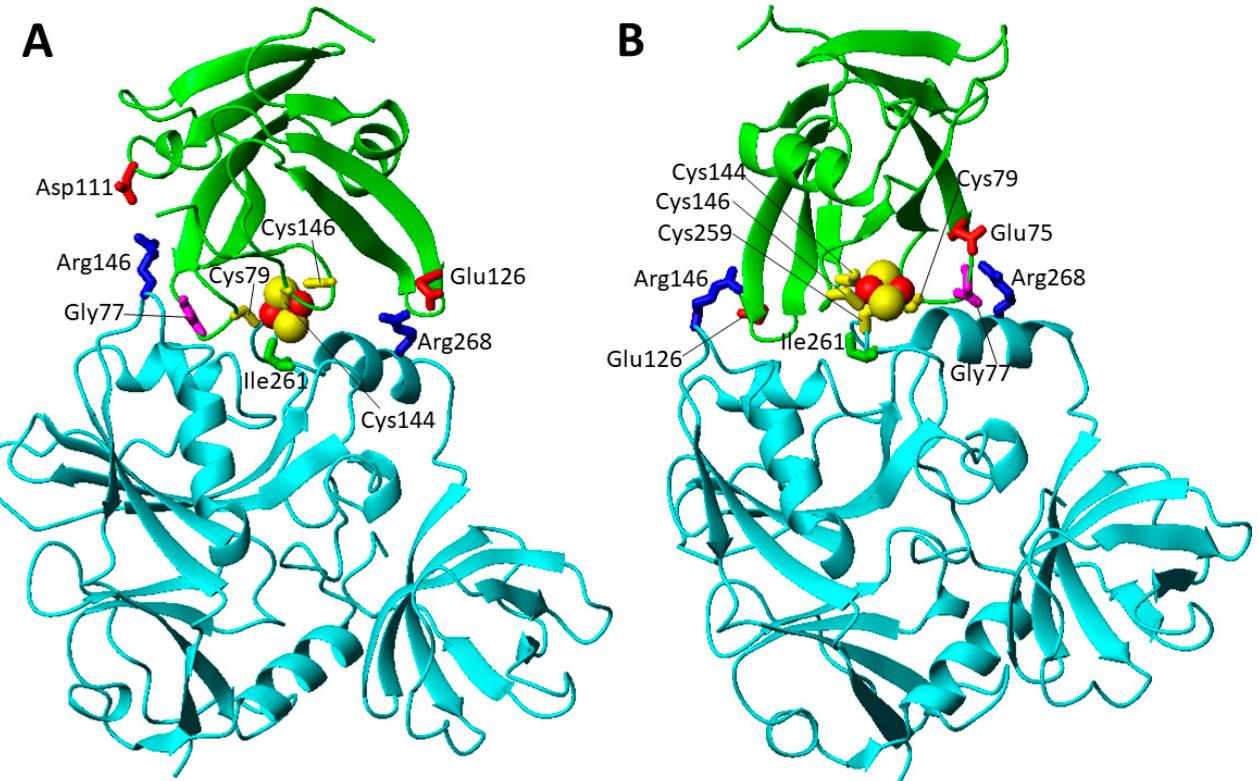
Figure 6. Effects of the pathogenic missense mutations on the heterodimeric [2Fe-2S] ISCA2-IBA57 complex. Ribbon diagrams of the two structural models of [2Fe-2S] ISCA2-IBA57 available from a data-driven docking approach [29] are shown in panels ( A ) and ( B ). IBA57 is in cyan and ISCA2 is in green. The sidechains of the four Cys ligands are shown as yellow stick, the iron and sulfur atoms of the [2Fe-2S] cluster are in red and yellow spheres, respectively. The side chains (involved in in- termolecular electrostatic interactions) of Asp111 (red, ISCA2) and Arg146 (blue, IBA57) and of Glu126 (red, ISCA2) and Arg268 (blue, IBA57) in ( A ), and of Glu75 (red, ISCA2) and Arg268 (blue, IBA57) and Glu126 (red, ISCA2) and Arg146 (blue, IBA57) in ( B ) are shown as sticks. The backbone of Gly77 (magenta, ISCA2) and the side chain of Ile261 (green IBA57) are also shown as sticks on both models.